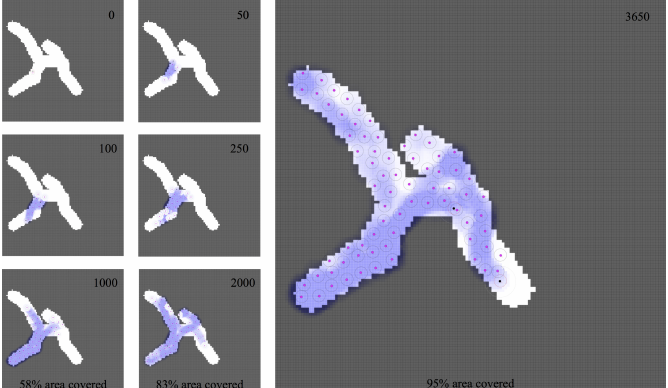
Figure 10. Behavioral trace for different simulation steps. Each simulation step is equivalent to 1/2 s. An enlarged area of the simulation is shown when the target case (95% coverage of the map area) is reached. The figure shows robots (in red), their detection area (concentric gray line with the robot), and the pheromone map maintained by the beacon robots